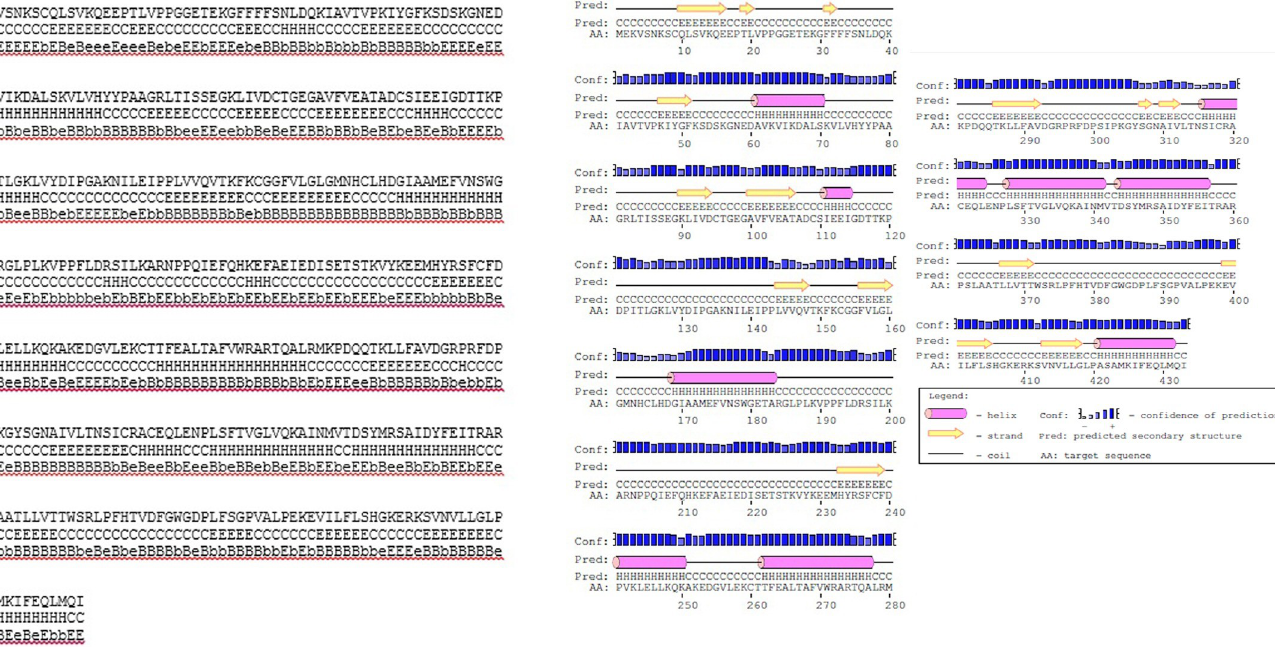
Fig 3. The secondary structure of T5AT protein prediction with PORTER program. Query-length: 433. H = Helix. E = strand. C = Coil. B = much buried. b = somewhat buried. e = somewhat exposed. E = very exposed.